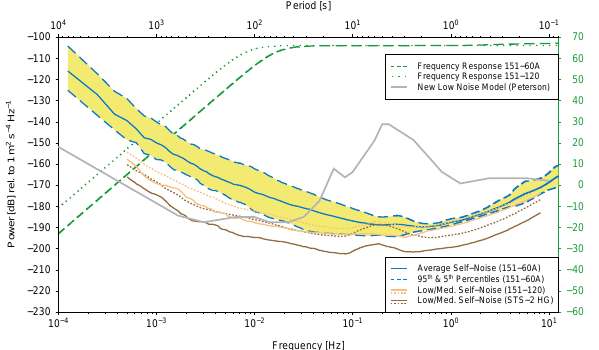
Fig. 5. Sensitivity study as to how much the misalignment of one sensor in a triple of sensors influences self-noise estimates partic- ularly in the microseismic band. As can be seen, the leakage is quite significant, reaching more than 10dB at 0.3Hz for 0.5 ◦ of misorientation. Self-noise estimates of the other two sensors (not shown here) exhibit only very small variations since they are still well aligned with each other.